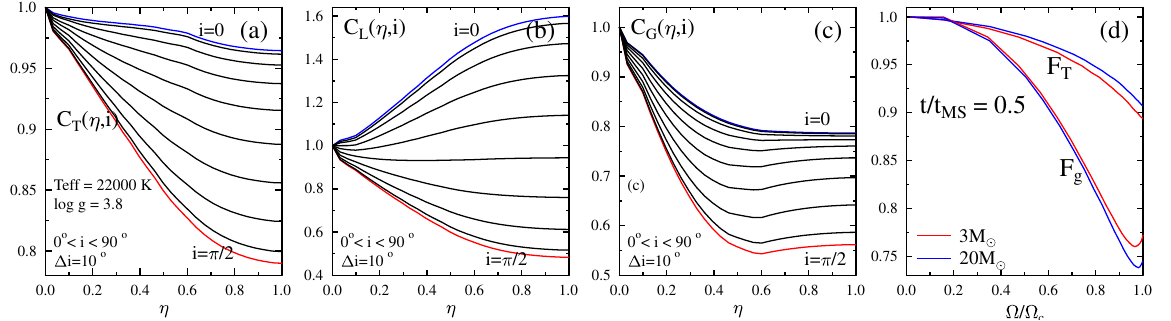
Figure 20. ( a ) Function C T ( M , t , η , i ) ; ( b ) function C L ( M , t , η , i ) ; and ( c ) function C g ( M , t , η , i ) . The = 20,000, log g pnrc = 3.8 and inclination angles in the interval pnrc parameters used here are T pnrc eff 0 ≤ i ≤ π /2 at steps ∆ i = 10 o . ( d ) Functions F T and F g are for t / t MS = 0.5 and two stellar masses. Adapted from Zorec et al.